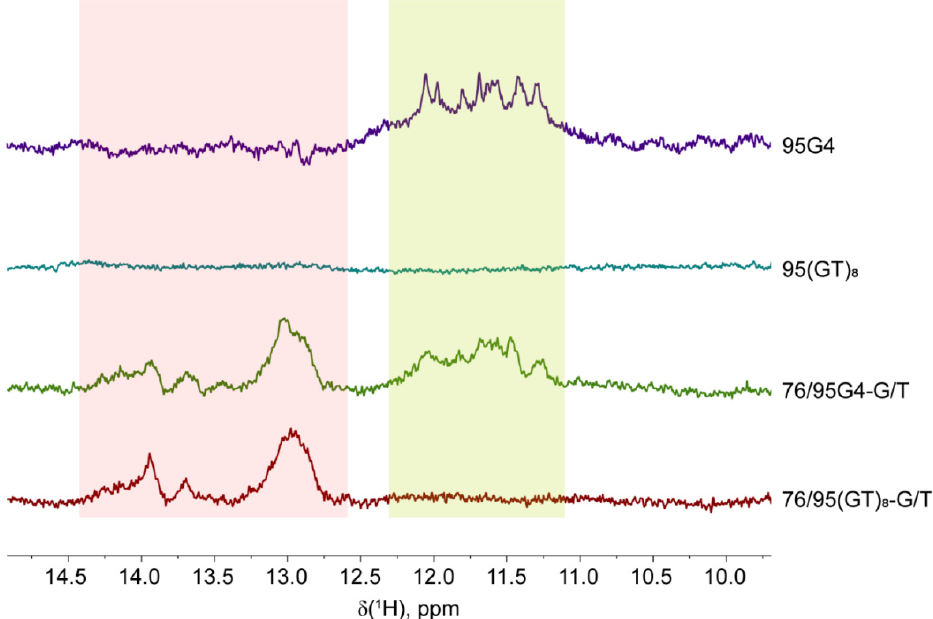
Figure 2. 1 H NMR spectra of single- and double-stranded DNAs. The peaks belonging to the exchangeable imino protons of the guanines involved in G-quartet formation are highlighted in yellow. The region characteristic of imino protons participating in Watson–Crick base pairing is highlighted in pink. The spectra were acquired on a 600 MHz spectrometer at 25 °C in 10 mM potassium phosphate buffer (pH 8.0) supplemented with 50 mM KCl. DNA concentrations were ~0.2 mM.